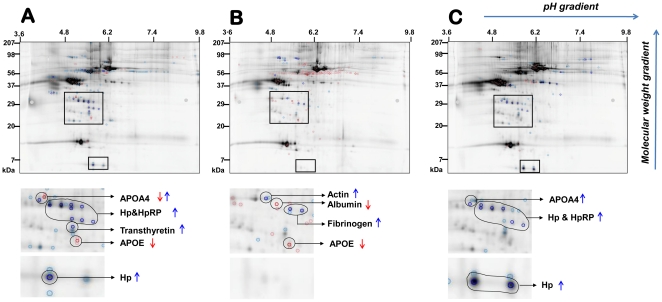
Merged 2D-DIGE images of the 3 gels used during the proteomics discovery phase and representative spots identified by mass spectrometry.Spots upregulated at least 1.5-fold are outlined in blue and spots down-regulated at least 1.5-fold are outlined with red. The squared regions are shown magnified below each gel (A, B or C) with matched unambiguous protein identities and direction of change represented by arrows. Apo, apolipoprotein; Hp, haptoglobin; HpRP, haptoglobin-related protein.